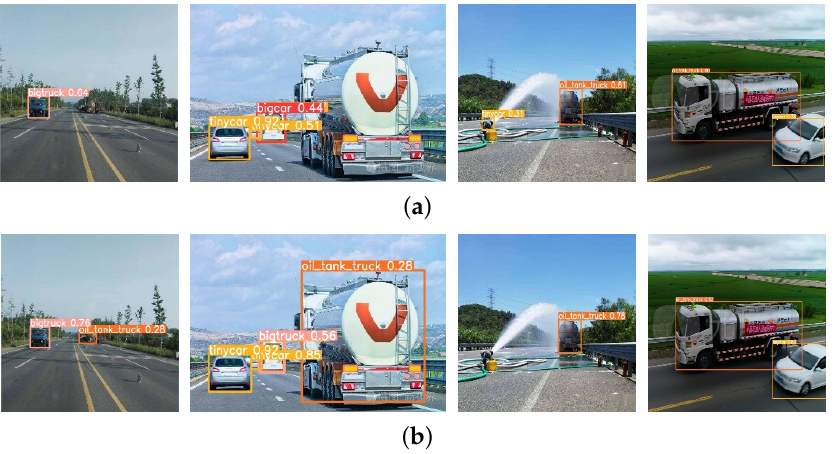
Figure 14. Comparison of the improved model with the original. ( a ) Original YOLOv5 experimental result. ( b ) Improved YOLOv5 experimental